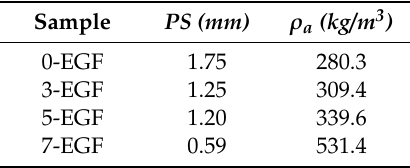
Table 4. Mean pore size (PS) and apparent density ( ρ a ) of the studied foams.